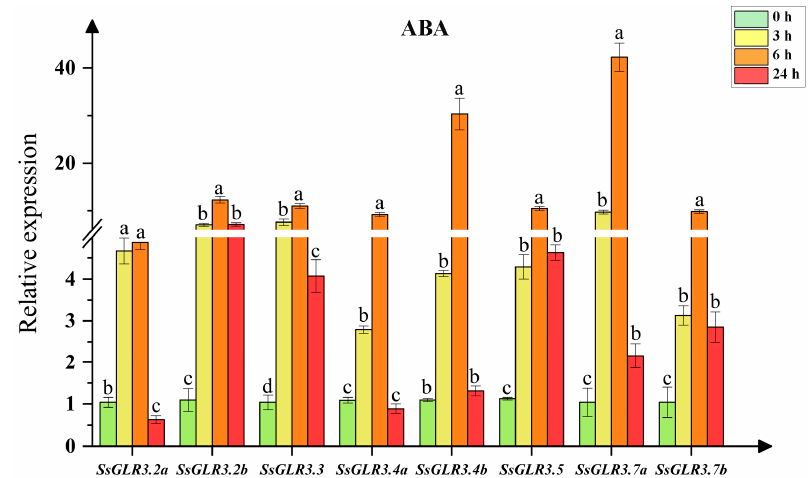
Figure 8. Expression of eight sugarcane GLR genes under hormonal stresses revealed by qRT-PCR analysis. ( A ) The cis -acting regulatory elements related to hormone response in eight sugarcane GLR genes in clade III. The color code on the right side of the figure was constructed by Origin 2021 (OriginLab Corporation, Northampton, MA, USA.) and showed the number of cis -acting regulatory elements ranging from gray (low number) to orange (high number). The number on the block represented the number of cis -acting regulatory elements. ( B ) The expression levels of eight sugarcane GLR genes in clade III under different hormone stresses. Simulated plant hormone stresses conditions, including 5 mM SA, 100 µ M MeJA, and 100 µ M ABA. All data points were means ± SE ( n = 3). Different lowercase letters indicated a significant difference, as determined by the least significant difference test ( p -value <